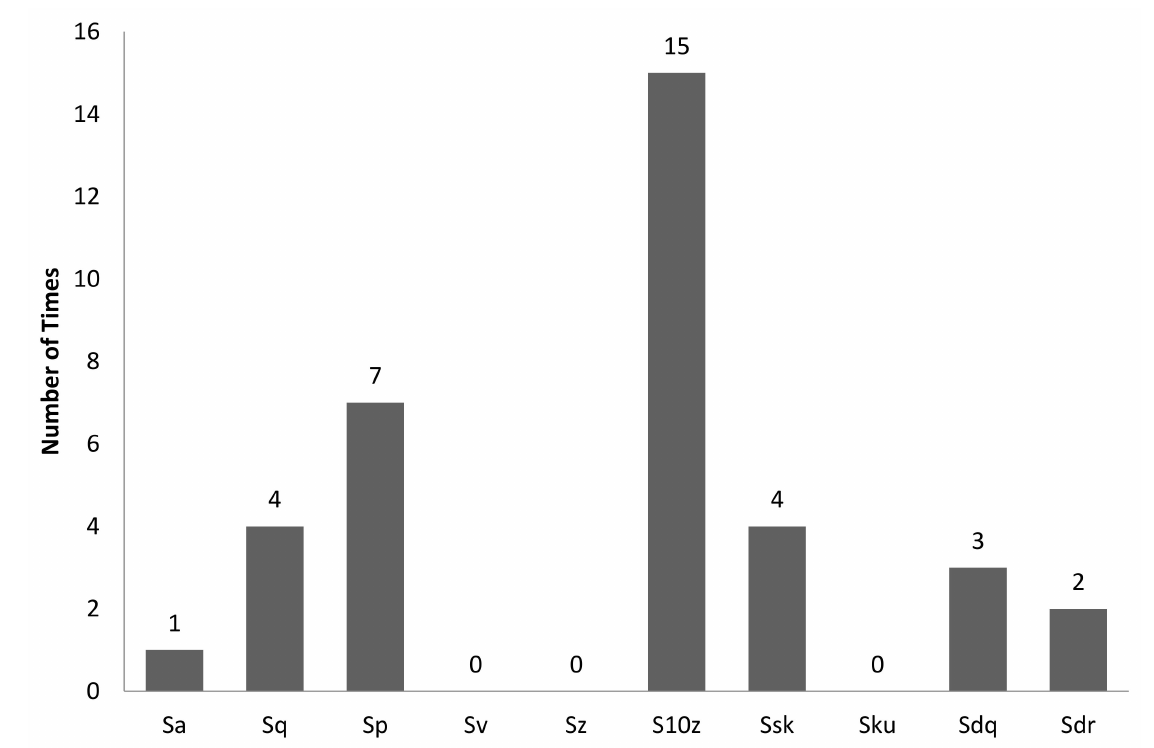
Figure 12. Bar chart showing the number of times a 3D surface roughness parameter was involved in correlation with R 2 ≥ 0.7 for an illumination angle of 45 ◦ for experimental setup 1.